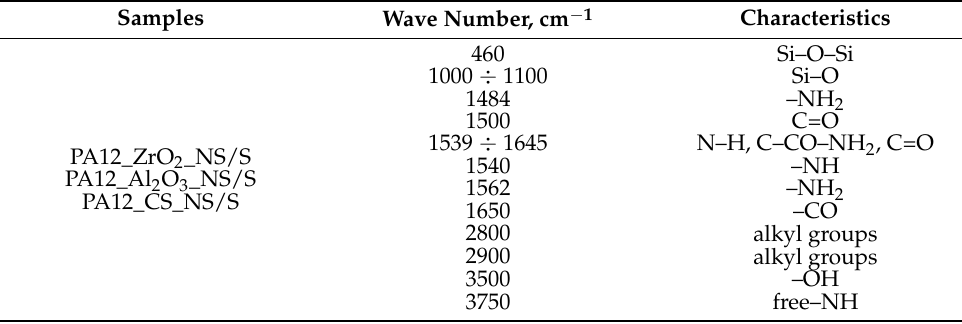
Table 8. IR band description for PA12_ZrO 2 , PA12_Al 2 O 3 , and PA12_CS samples.